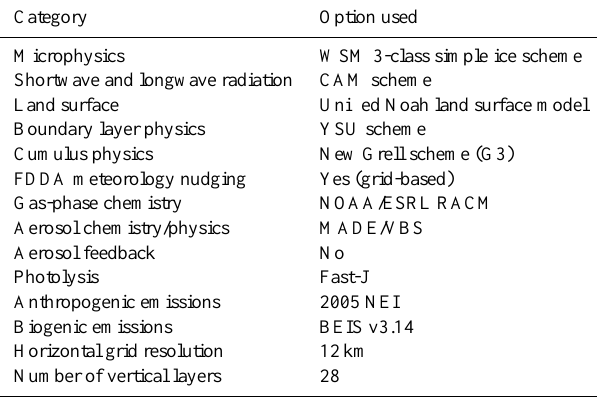
Table 1. Selected WRF-Chem v3.4 settings and parameters em- ployed in this